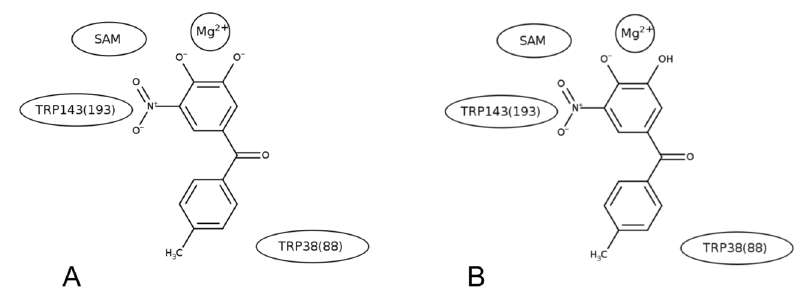
Figure 5. Crystallographic orientation of tolcapone in the MD simulations. ( A ) Doubly deprotonated tolcapone and ( B ) singly deprotonated tolcapone.